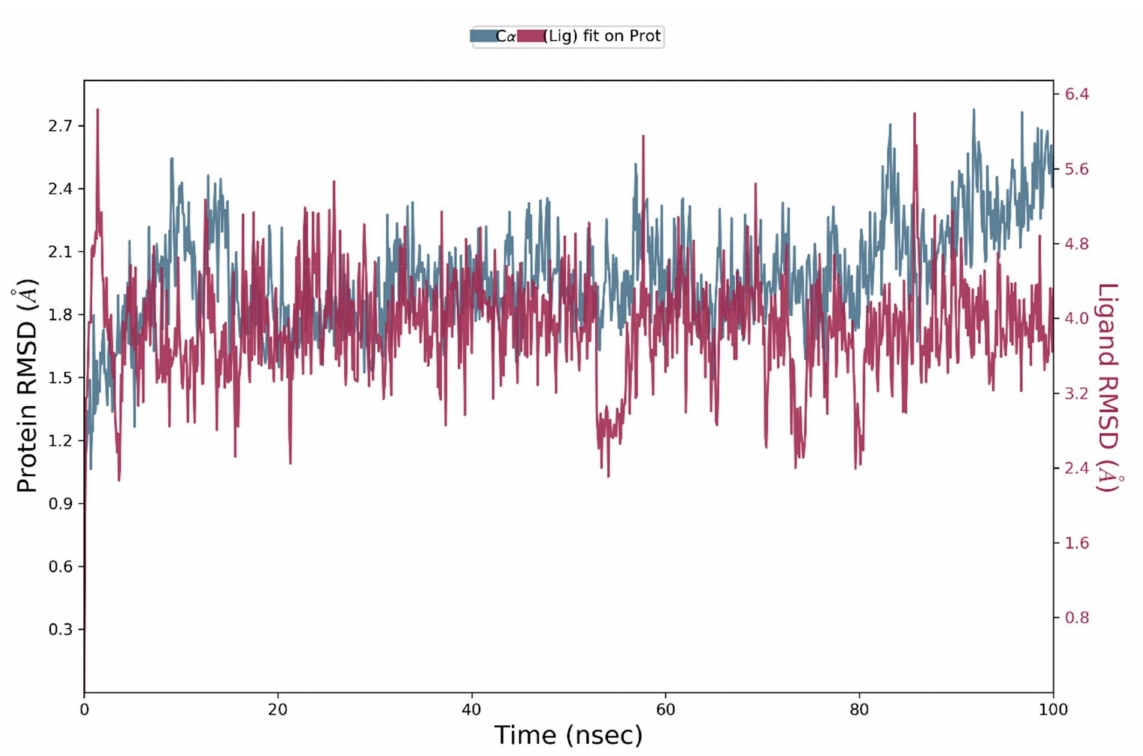
Figure 11. Residue wise root-mean-square deviation (RMSD) of the C-alpha atoms of NEK7 (2wqn) and Dabrafenib Complex.